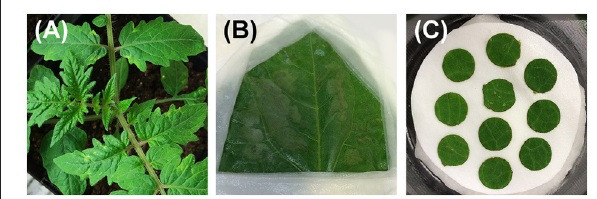
FIGURE 6 | Phytotoxicity from Neo-Boost spraying. (A) A tomato plant from the priming experiment on the last day of spraying with neo-boost. Spots with yellowing represent the extent of phytotoxicity. (B) A detached bean leaf 48 hours post-infestation and spraying. Phytotoxicity was most evident in this experiment, where neo-boost did not dry completely after spraying in some spots. (C) Only a small amount of phytotoxicity was observed in the leaf-disk set-up, as neo-boost rarely pooled within